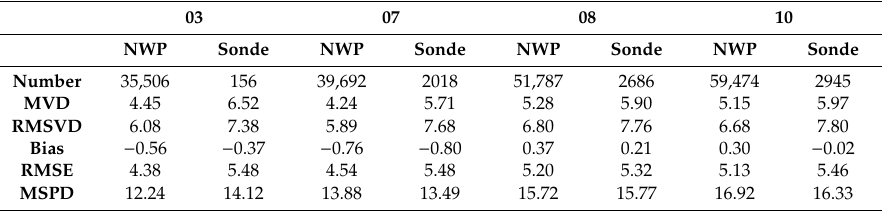
Table 6. Validation scores of GK-2A AMVs compared with ECMWF and rawinsonde profiles in the prescribed configuration for both 05:40 and 12:10 UTC on 21 July 2016. All AMVs with CQIF > 80 were collected.